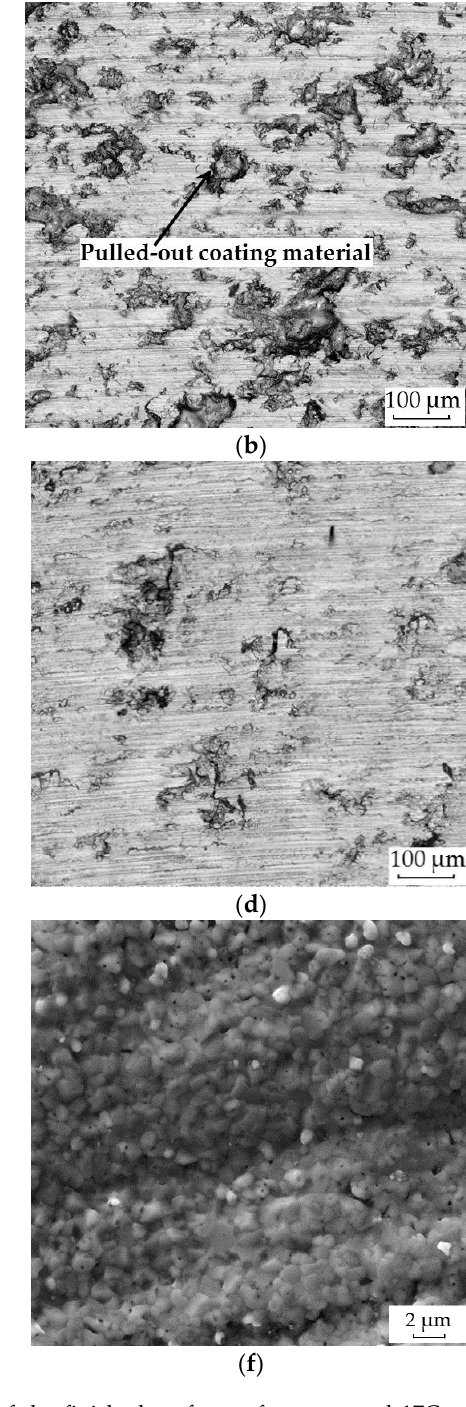
Figure 4. Laser scanning microscope images of the finished surfaces of arc sprayed 17Cr-steel coatings: ( a ) finished with machining parameter f1; ( b ) gas nitrided and finished with f1; ( c ) gas nitrided and finished with f2; ( d ) gas nitrided and finished with f3; ( e , f ) finished with f1 and gas nitrided with ( f ) showing an SEM image recorded with the secondary electrons (SE) detector.